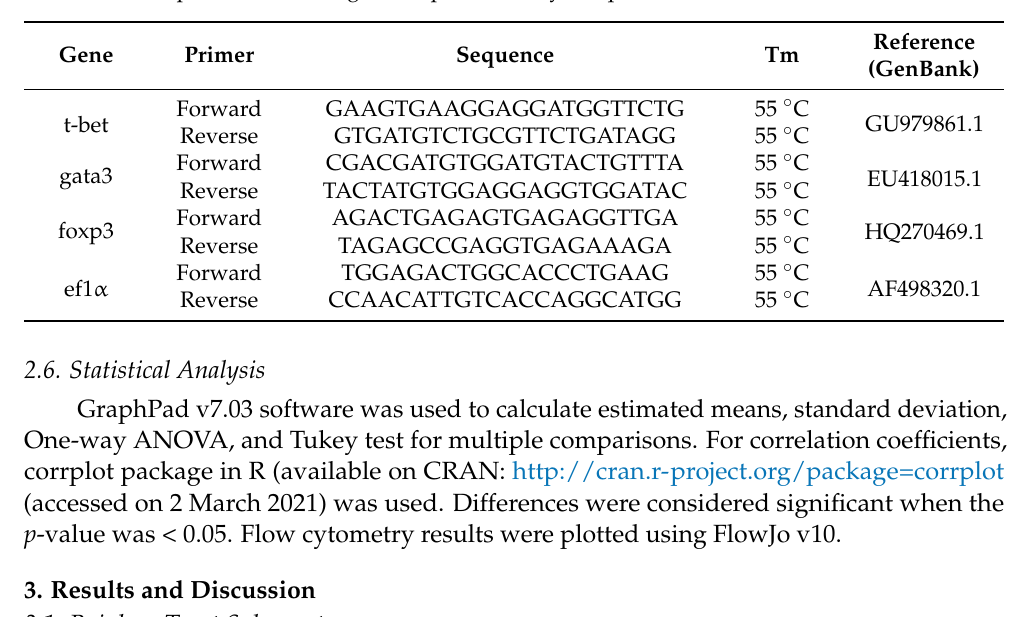
Table 2. List of primers used for gene amplification by